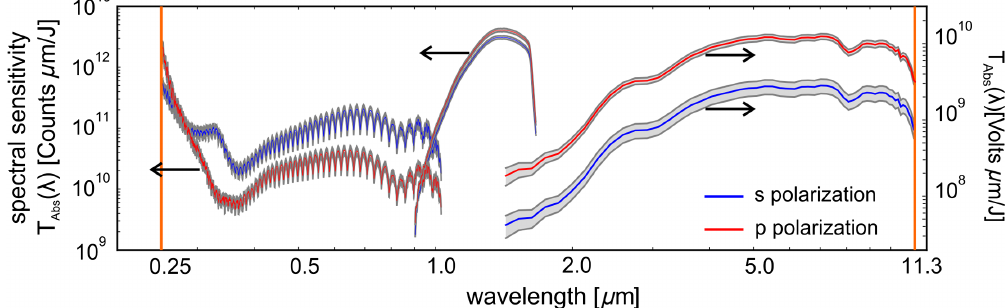
FIG. 16. Overview over the bandwidth-corrected absolute instrument calibration: The three sets of calibration curves represent the spectral range of the three independent detectors. Each set is presented with respect to s- and p-polarization as indicated in blue and red, respectively. The gray area indicates the error contributions from the wavelength, relative, and absolute calibrations. Arrows indicate the associated